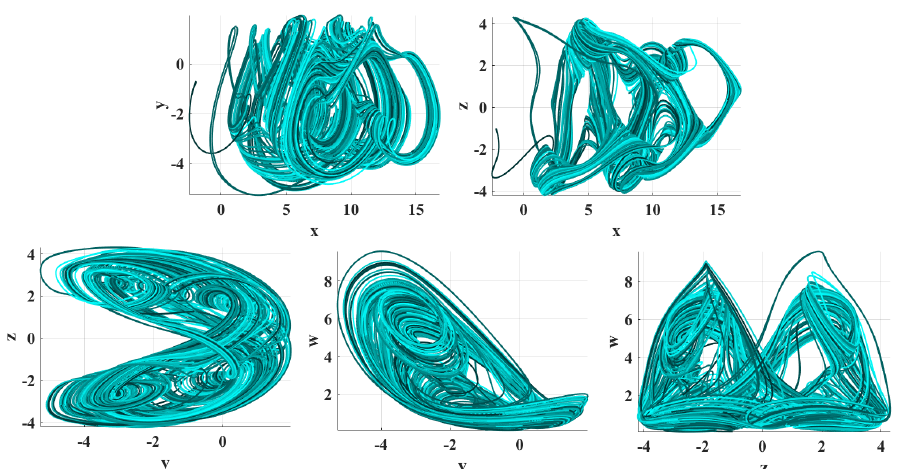
Figure 1. The fractional memristive system in five projections.